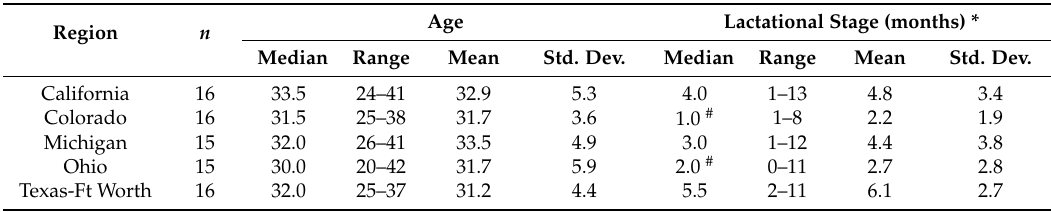
Table 1. Age and lactational stage of donors by milk